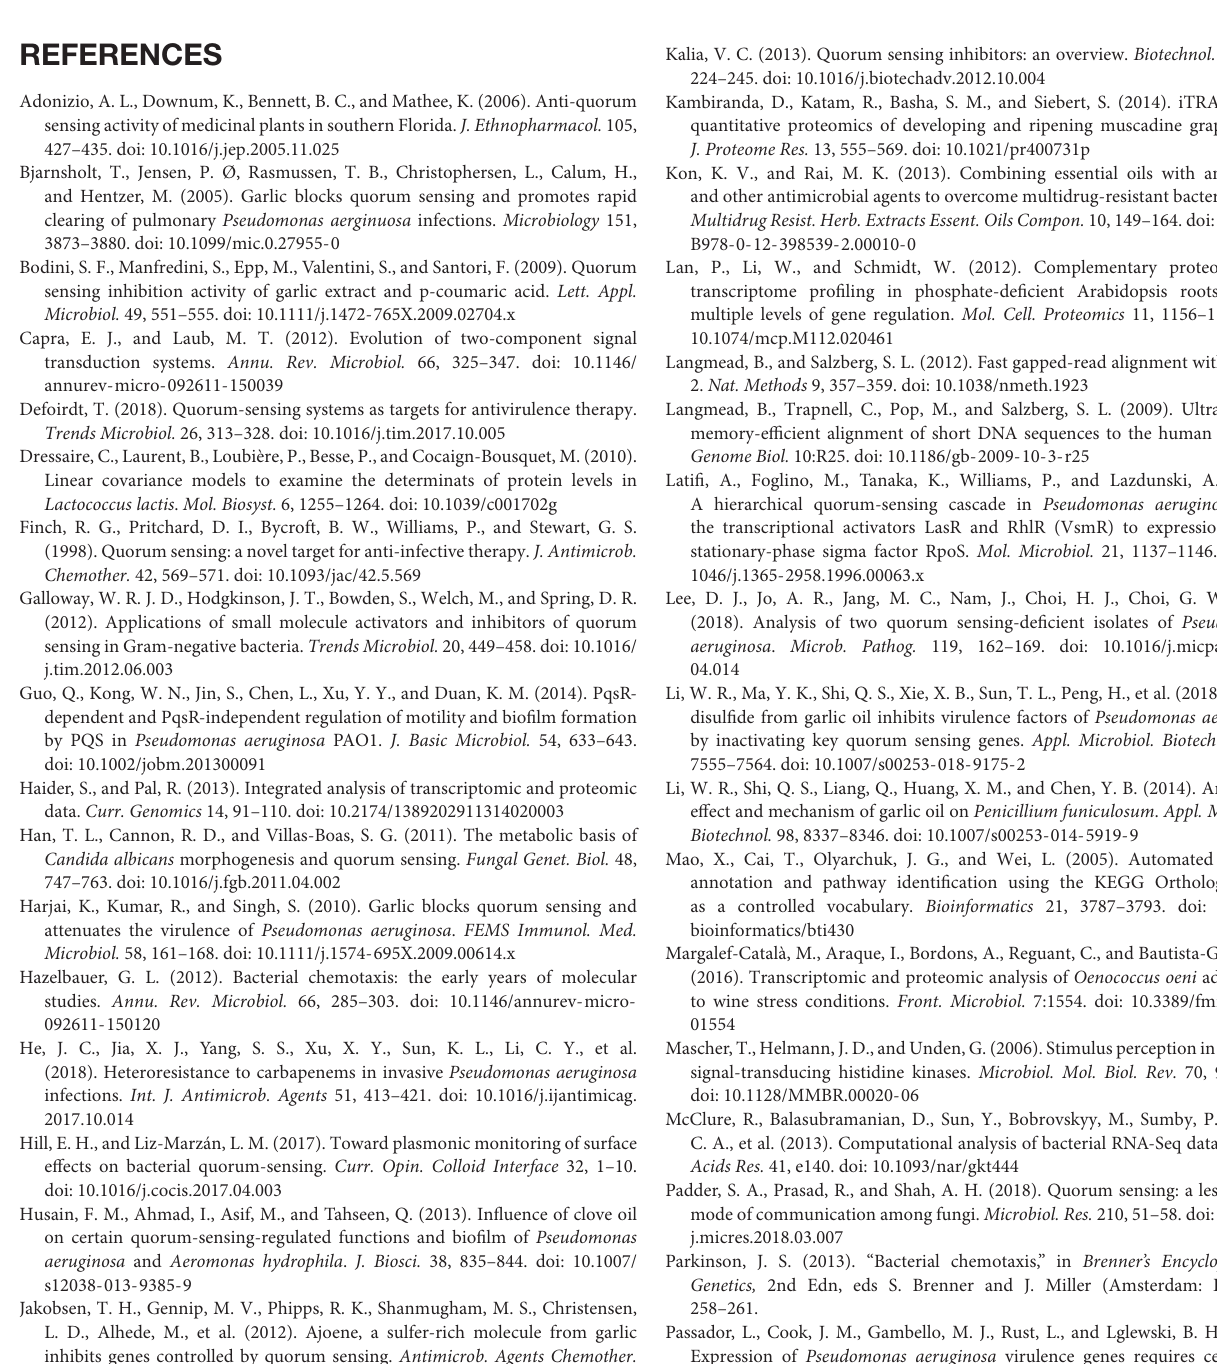
TABLE S2 | Differentially expressed gene data of DADS-treated Pseudomonas aeruginosa PAO1 vs. control groups based on RNA-seq analysis.